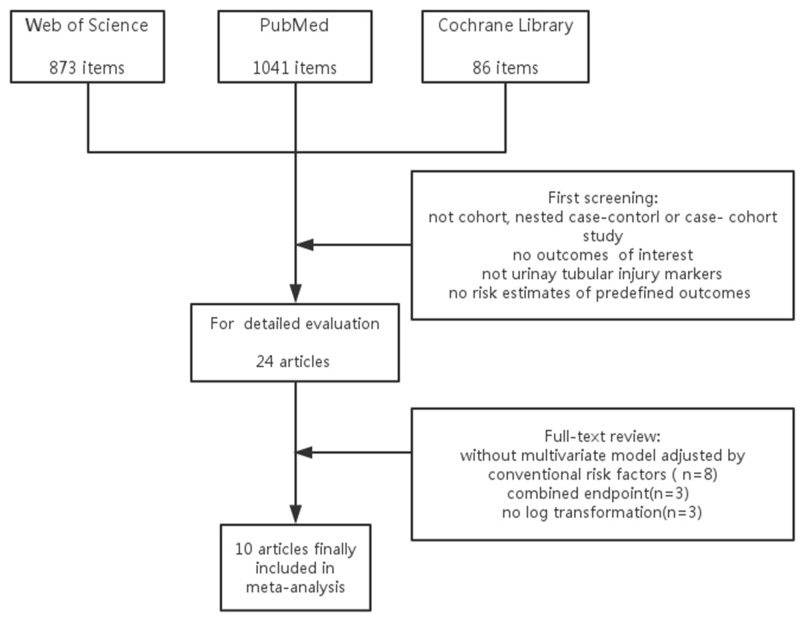
Flow Chart of Literature Search Process.